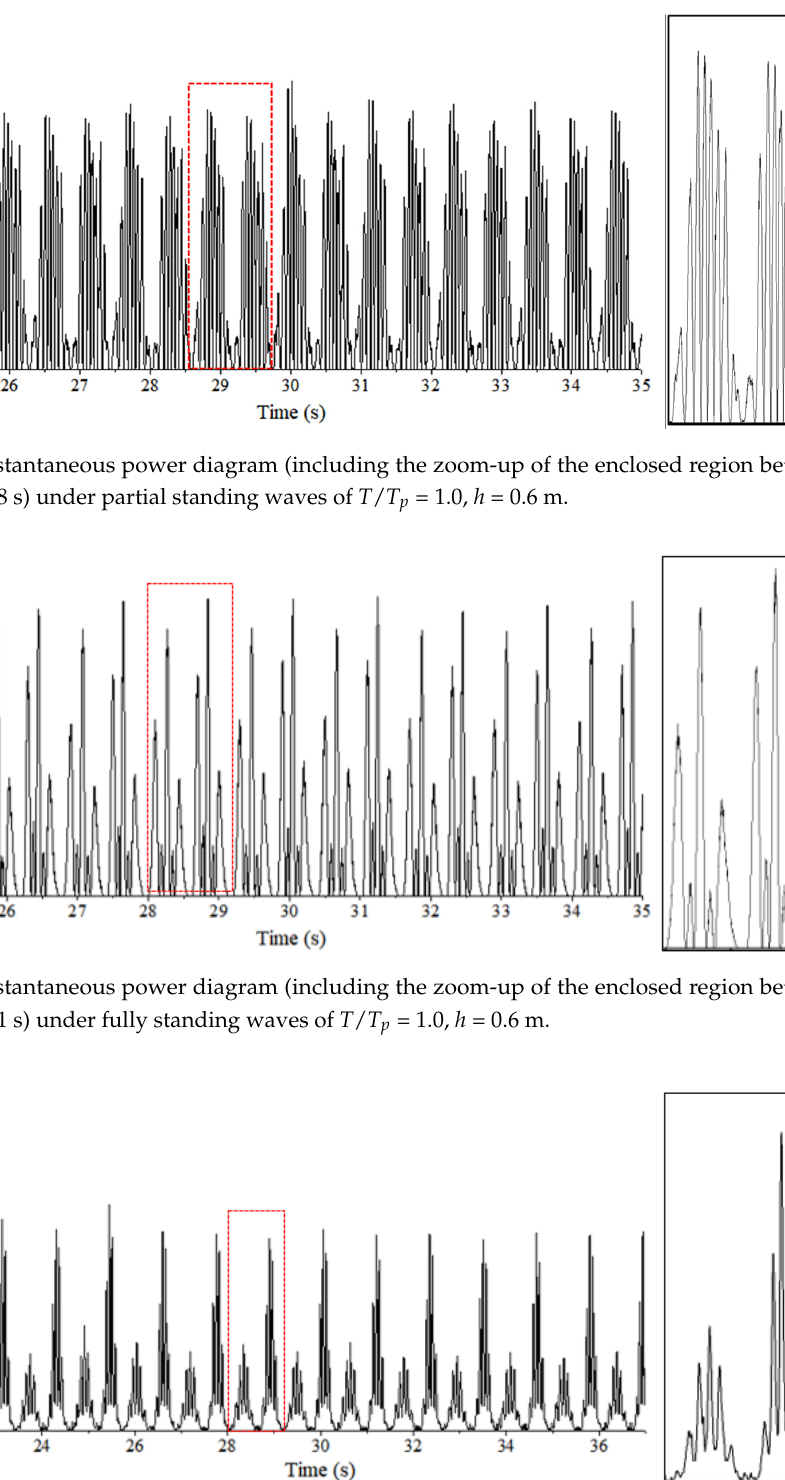
Figure 17. Instantaneous power diagram (including the zoom-up of the enclosed region between 28.0 s and 29.2 s) under traveling waves of T / T p = 1.0, h = 0.6 m.